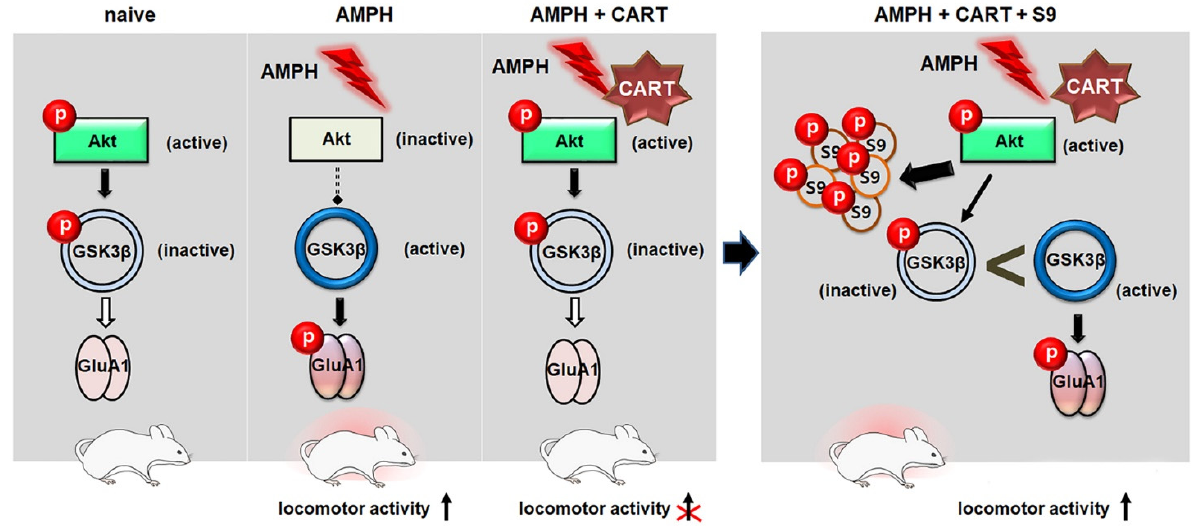
Figure 6. A hypothetical model incorporating present findings illustrates a signal pathway where AMPH and CART peptide 55–102 interact. The left panel shows that acute AMPH decreases phosphory- lation levels of Akt and GSK3 β with a concurrent increase of phosphorylation levels of GluA1 in the NAcc core, which increases locomotor activity. These effects are blocked by CART peptide 55–102 in the NAcc core. The right panel shows that the presence of S9 peptide, by competing with endog- enous GSK3 β against its phosphorylation site, abolishes the inhibitory action of CART peptide on the phosphorylation levels of GSK3 β and GluA1, and consequently, locomotor activity induced by